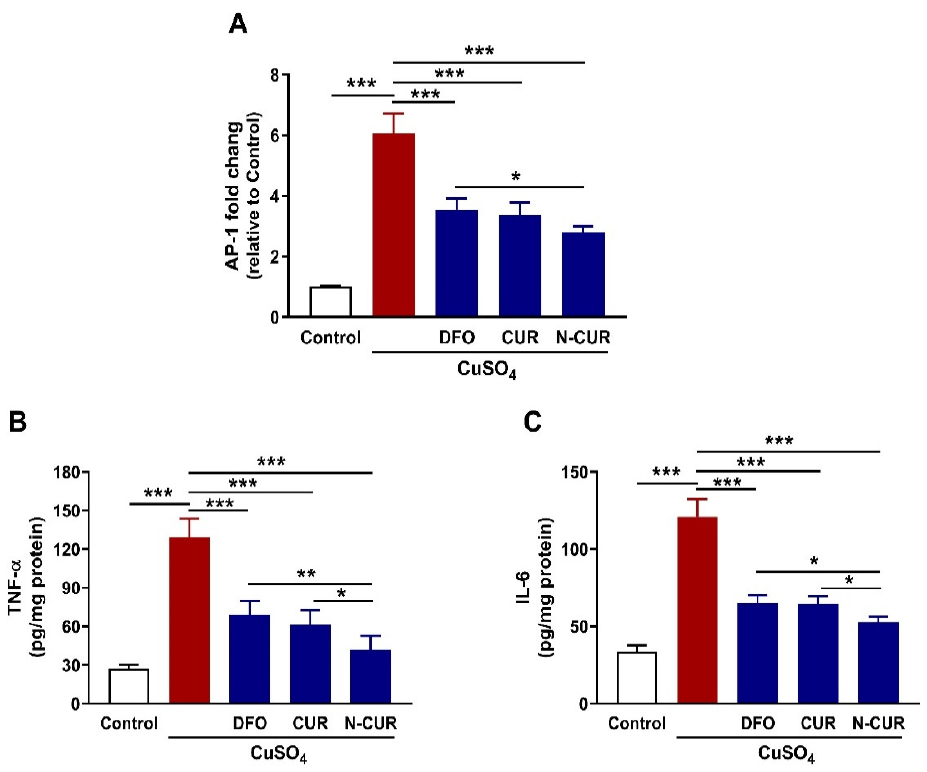
Figure 5. N-CUR and CUR downregulated cardiac AP-1 mRNA abundance ( A ), TNF- α ( B ) and IL-6 ( C ) in Cu-intoxicated rats. Data are mean ± SD, ( n = 8). * p < 0.05, ** p < 0.01 and *** p < 0.001.